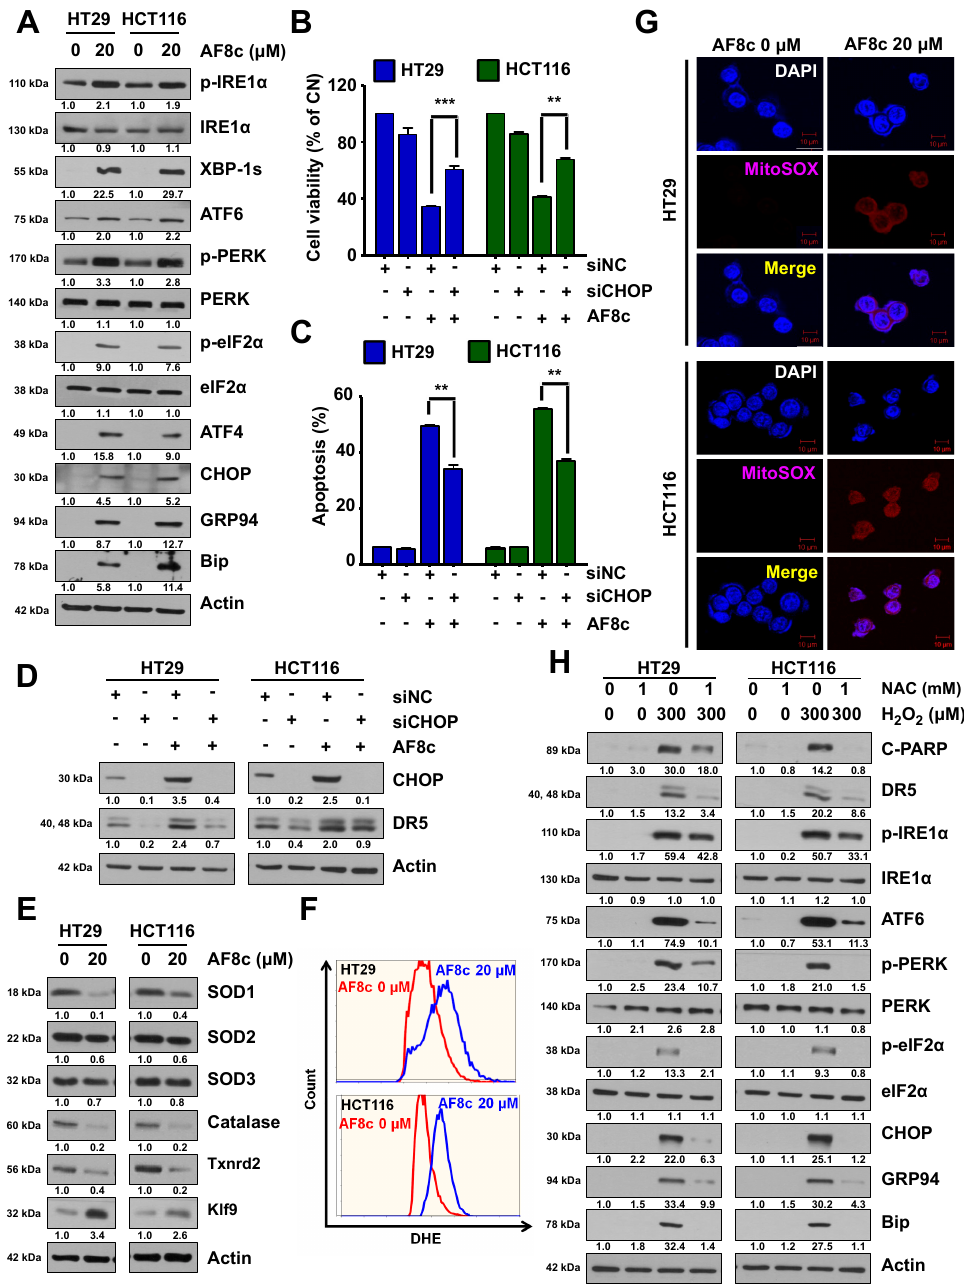
Figure 3. Excessive ROS and ER stress generation by AF8c treatment contribute to DR5-mediated apoptosis: ( A ) HT29 (left) and HCT116 (right) cells were exposed to 20 μ M AF8c for 24 h, and the expression levels of ER stress-related proteins were examined by Western blot; ( B – D ) the indicated CRC cells were treated with siNC or siRNAs for CHOP (siCHOP) for 18 h. The cells treated with 20 μ M AF8c were then analyzed using WST-1 assay ( B ); FACS analysis ( C ); and Western blotting ( D ). **, p < 0.01 and ***, p < 0.001. ( E ) After incubating HT29 (upper) and HCT116 (lower) cells with AF8c, ROS levels were measured using immunofluorescence; ( F , G ) the AF8c-treated HT29 (upper) and HCT116 (lower) cells were stained with 10 μ M DHE (F); and MitoSOX ( G ). The cells were then observed by flow cytometry and confocal microscopy (Scale bar, 10 μ m). ( H ) HT29 (left) and HCT116 (right) cells were treated with 300 μ M H 2 O 2 for 24 h, and the expression levels of Cleaved PARP, DR5, and ER stress-related proteins were analyzed by immunoblotting. 3.4. Activation of DR5-Induced Nrf2 by AF8c Is a Prerequisite for Apoptotic Cell Death